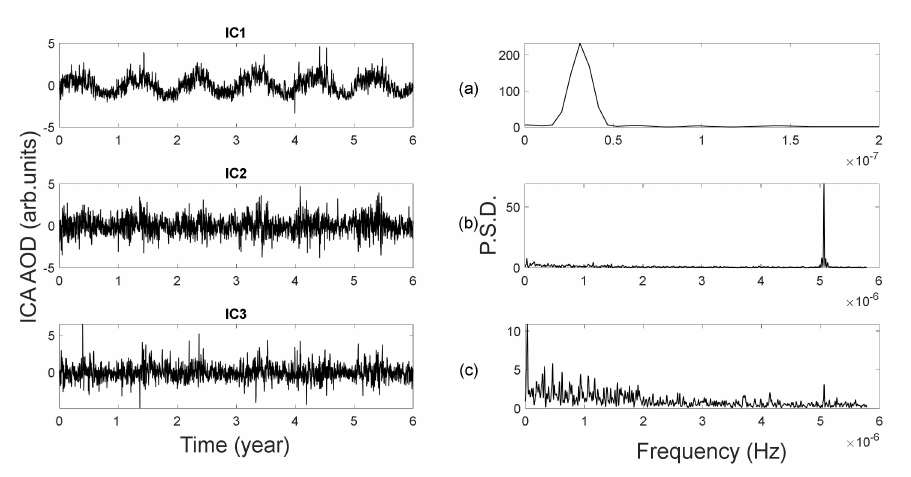
Figure 3. Independent Component Analysis (ICA) extracted components and relative PSDs: ( a ) The annual peak is always embedded in a background noise (IC1), linking noise to the deterministic part, whereas ( b ) a 2–3 day period (IC2) is completely separated; ( c ) residual is represented by